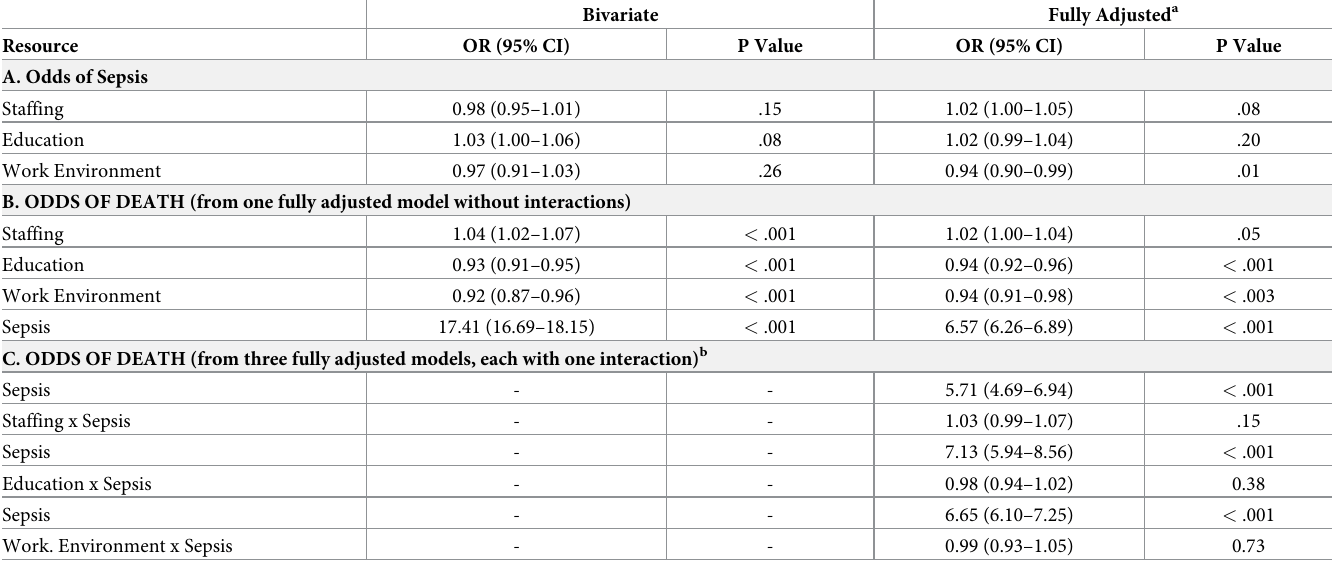
Table 4. The impact of nursing resources on odds of sepsis and